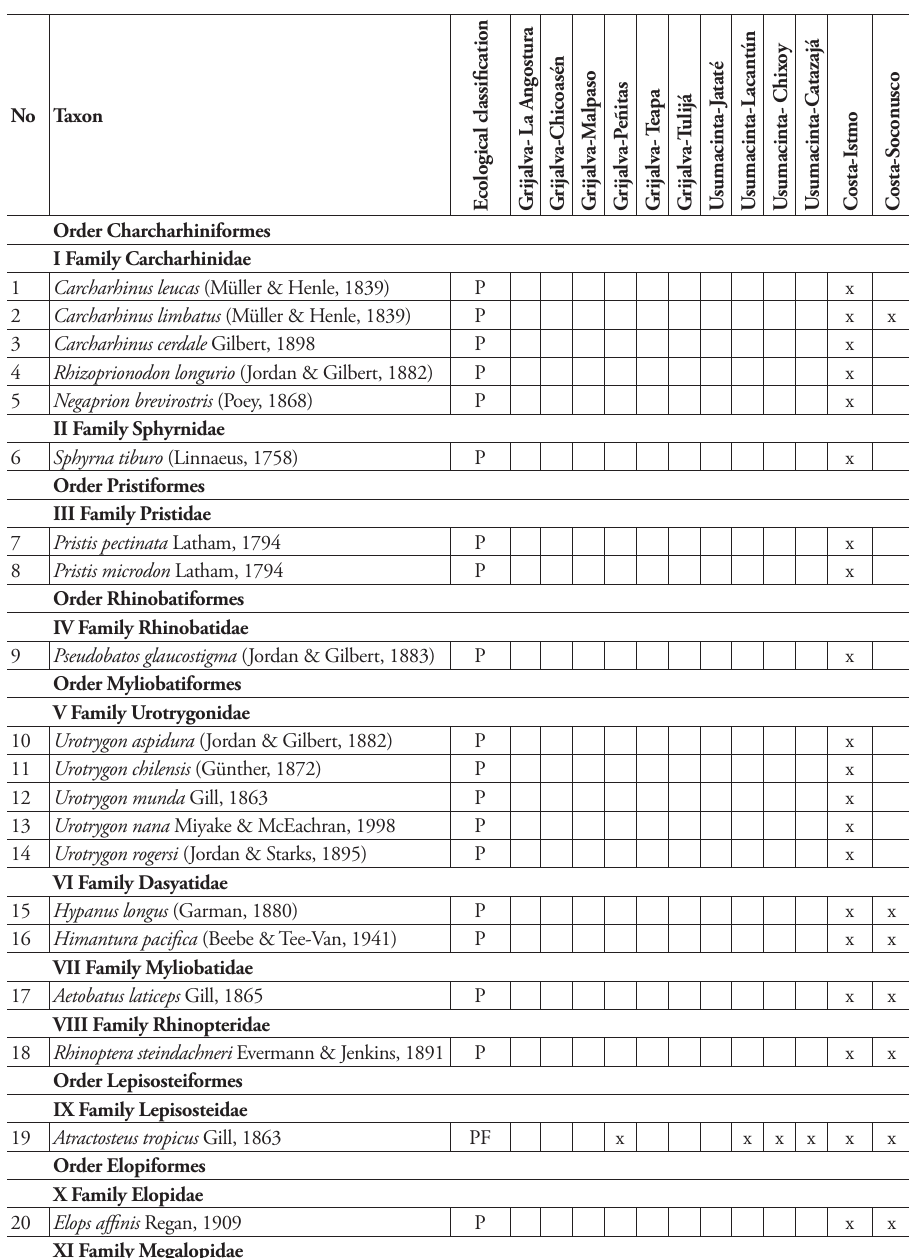
Table 2. Systematic list of the continental waters ichthyofauna of Chiapas. Ecological classification: PF (Primary Freshwater), SF (Secondary Freshwater), PF (Peripheral Vicarious), PC (Peripheral Catadro- mous), P (Peripheral), Ex